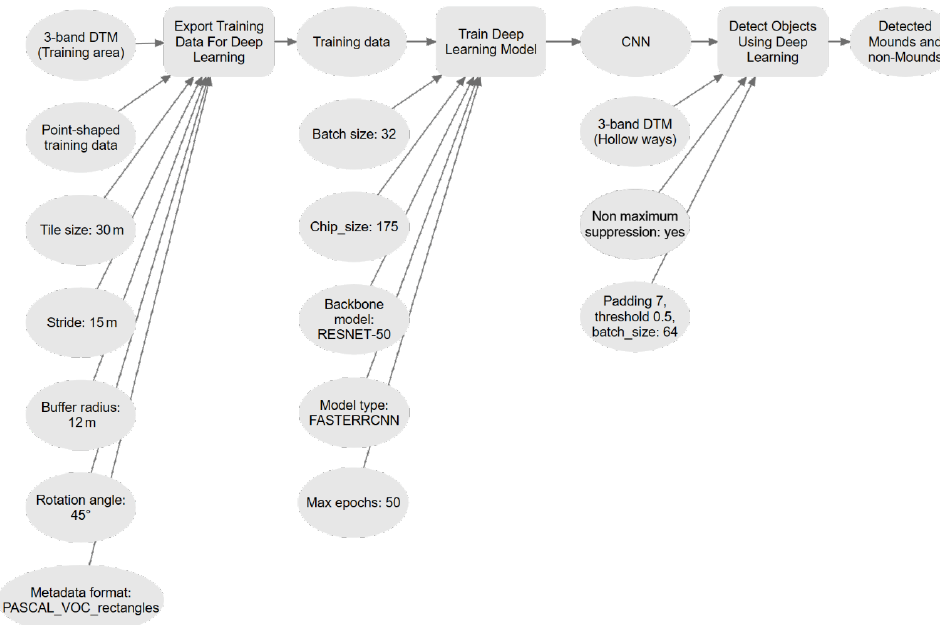
Figure 6. CNN training data export, training, and detection workflow.